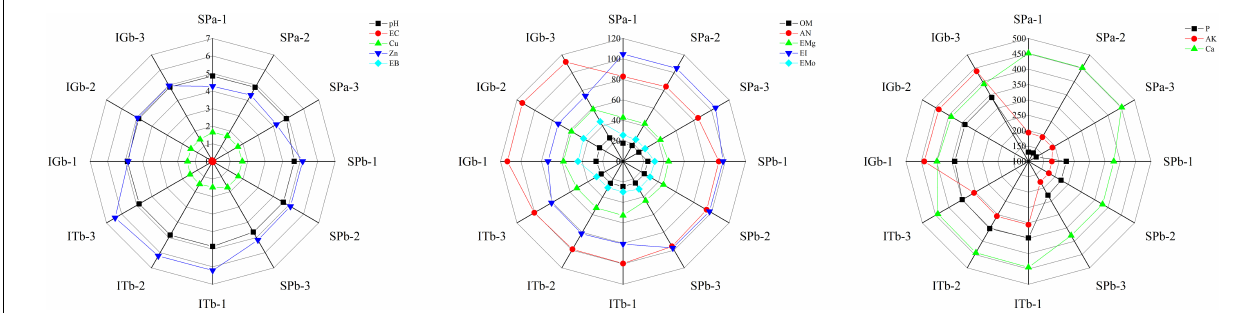
FIGURE 1 | Radar distributions of soil physical factors. The three diagrams have been divided according to the measured values of the soil physical properties. SPa, cropping with patchouli for 1 year; SPb, continuous cropping with patchouli over a number of years; ITb, continuous cropping with patchouli and intercropping with turmeric; and IGb, continuous cropping with patchouli and intercropping with ginger. P, available potassium; AK, available potassium; Ca, exchangeable Ca; EC, electrical conductivity; Cu, available Cu; Zn, available zinc; EB, effective boron; OM, organic matter; AN, alkali-hydrolyzable nitrogen; EMg, effective magnesium; EI, effective iron; EMo, effective